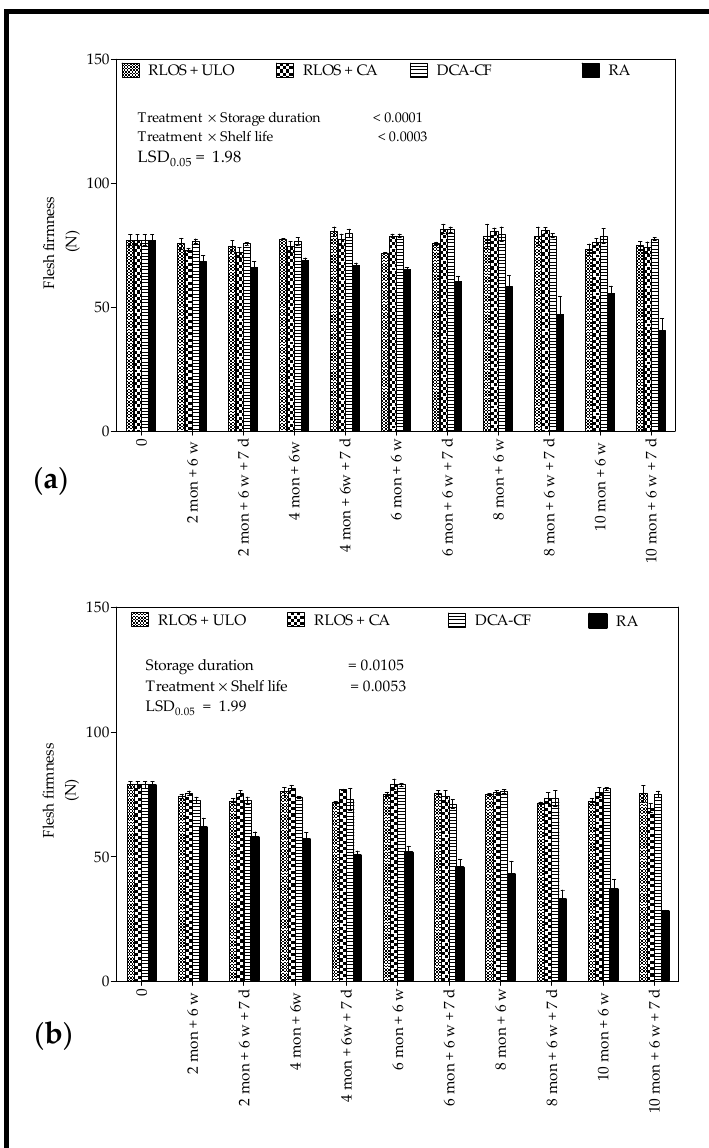
Figure 1. Firmness (N) of ‘Granny Smith’ apples harvested in the 2015 ( a ) and 2016 ( b ) seasons at commercial maturity and stored for up to 10 months at 0 ◦ C in various storage conditions, evaluated every two months followed by a 6 week simulated shipment and handling period, and at 7 days on the shelf (20 ◦ C and 65% RH). Vertical bars represent the standard error (SE) of mean values of 3 replicates (1 replicate = 10 fruit). LSD 0.05 represent least significant difference ( p < 0.05). For storage duration, mon—months, w—weeks, and d—days. RLOS—repeated low oxygen stress; ULO—ultra-low oxygen; CA—controlled atmosphere; DCA-CF—dynamic controlled atmosphere-chlorophyll fluorescence; RA—regular atmosphere.